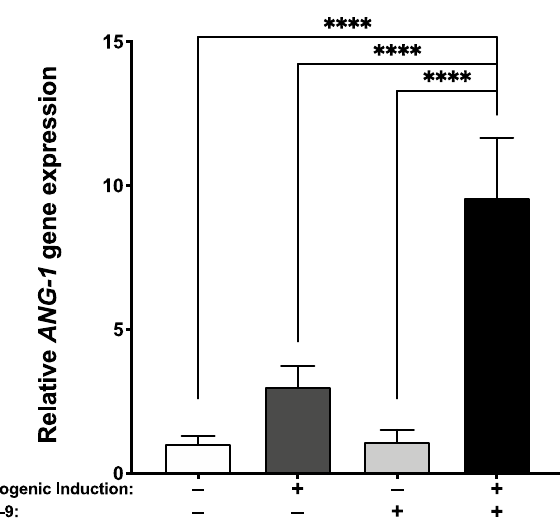
Figure 3. Superior expression of angiopoietin-1 transcript for the BMP-9 treated bone-like substitutes. Gene expression of angiopoietin-1 ( ANG-1 ) was measured by RT-qPCR after 21 days of tissue culture. (One-way ANOVA with a Bonferroni’s multiple comparison post-hoc test, **** p < 0.0001).